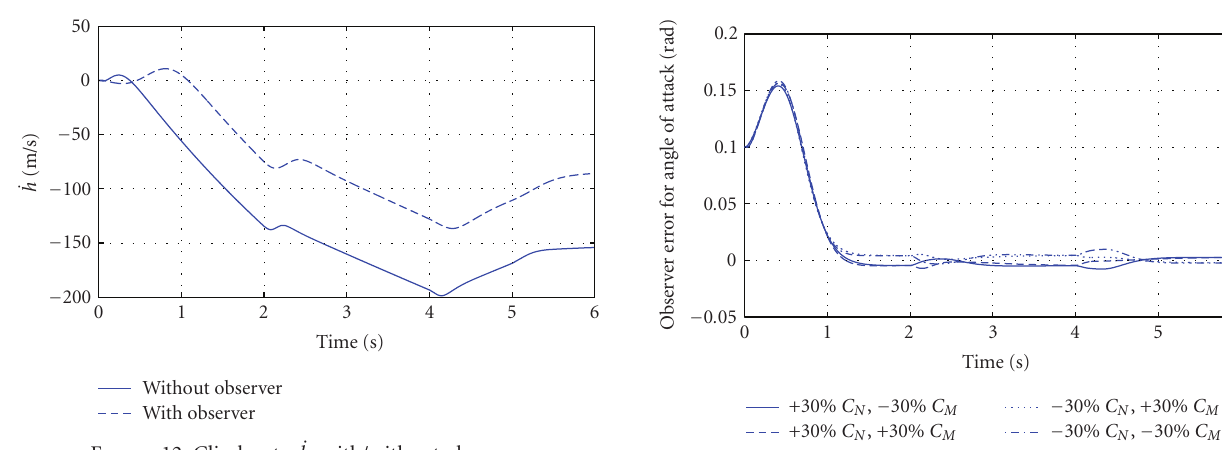
Figure 14: Tracking error for observer in presence of various parameter variations.